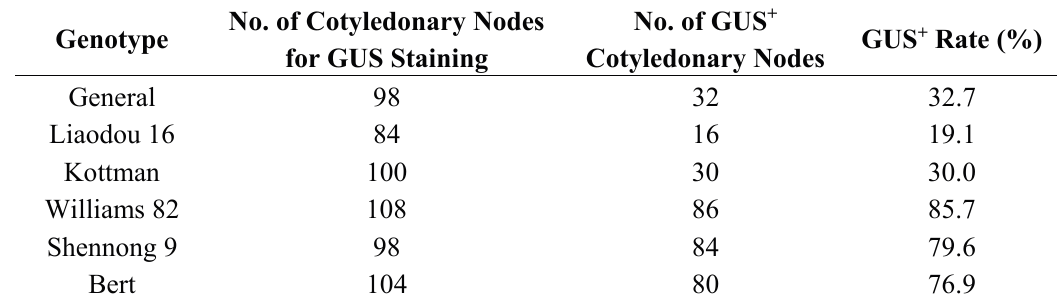
Transient GUS expression rate (%) = (No. of cotyledonary nodes with GUS staining/No. of cotyledonary nodes for GUS staining)